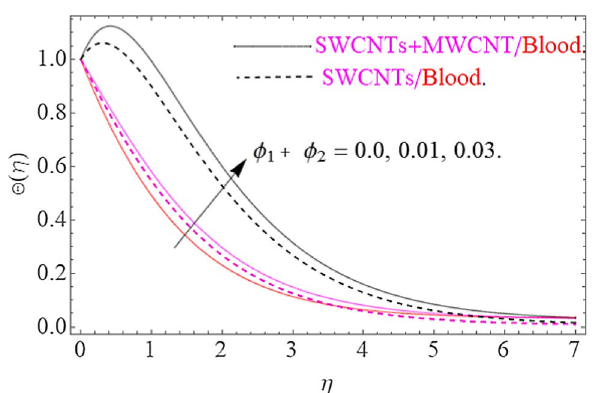
Figure 10. Effects of φ 1